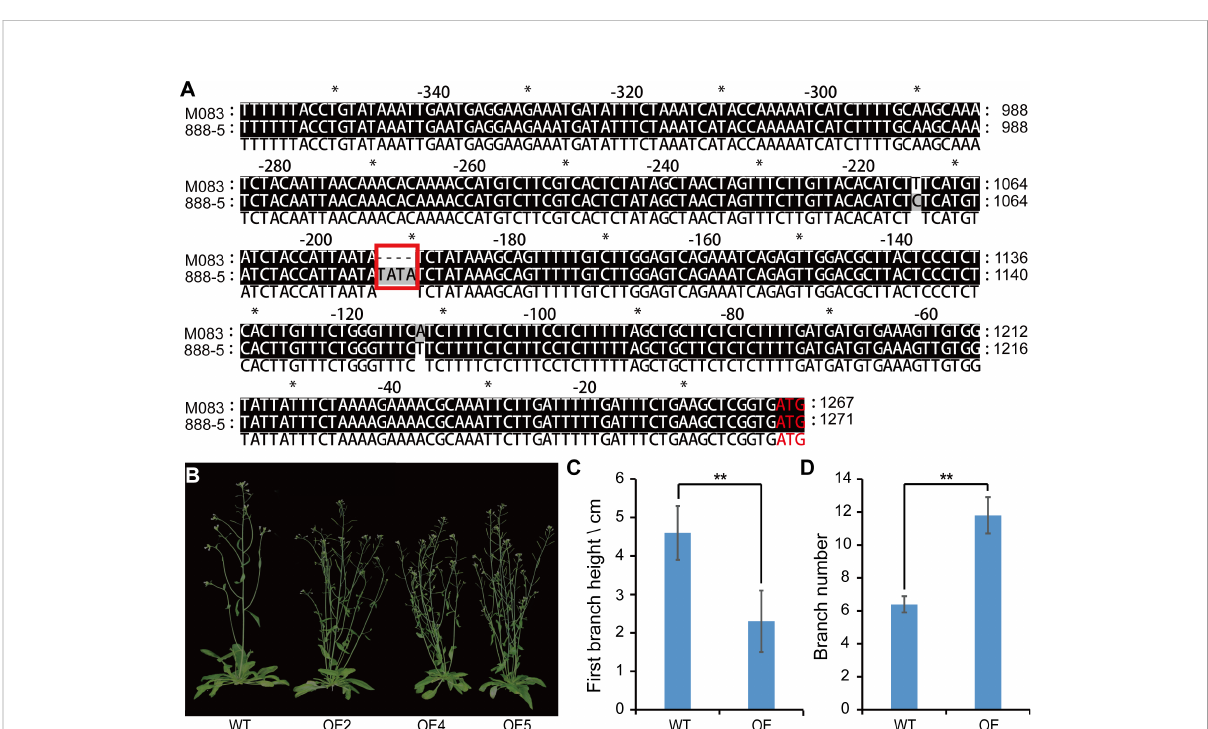
FIGURE 6 Sequence analysis and phenotypic comparison of wild type (WT) plants and the BnaA02.TCP1 M083 -OE lines in Arabidopsis . (A) Alignment of BnaA02.TCP1 promotor sequences between 888-5 and M083. The red rectangle represents the nucleotide change between 888-5 and M083. (B) Phenotype comparison of WT and BnaA02.TCP1 M083 overexpression (OE) lines in Arabidopsis at the grain fi lling stage. (C, D) Digital comparison of (C) FBH and (D) branch number between WT and OE lines in Arabidopsis . Data are presented as means ± SD (n = 10). The double asterisks represent a signi fi cant difference determined using Student ’ s t -test at P <